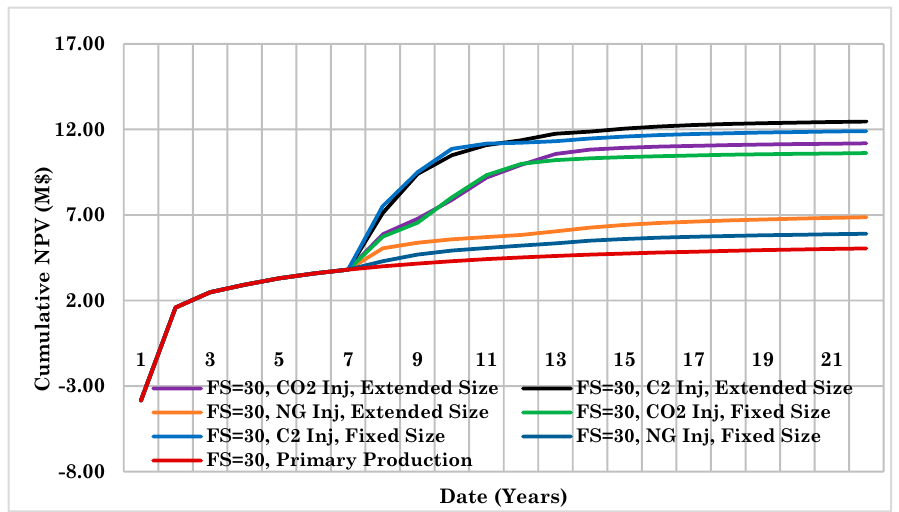
Figure 23. Cumulative NPV of the scenarios for fixed and extended cycles of cyclic CO2, C2 and NG injection as well as natural depletion, FS=30, Oil API=38.